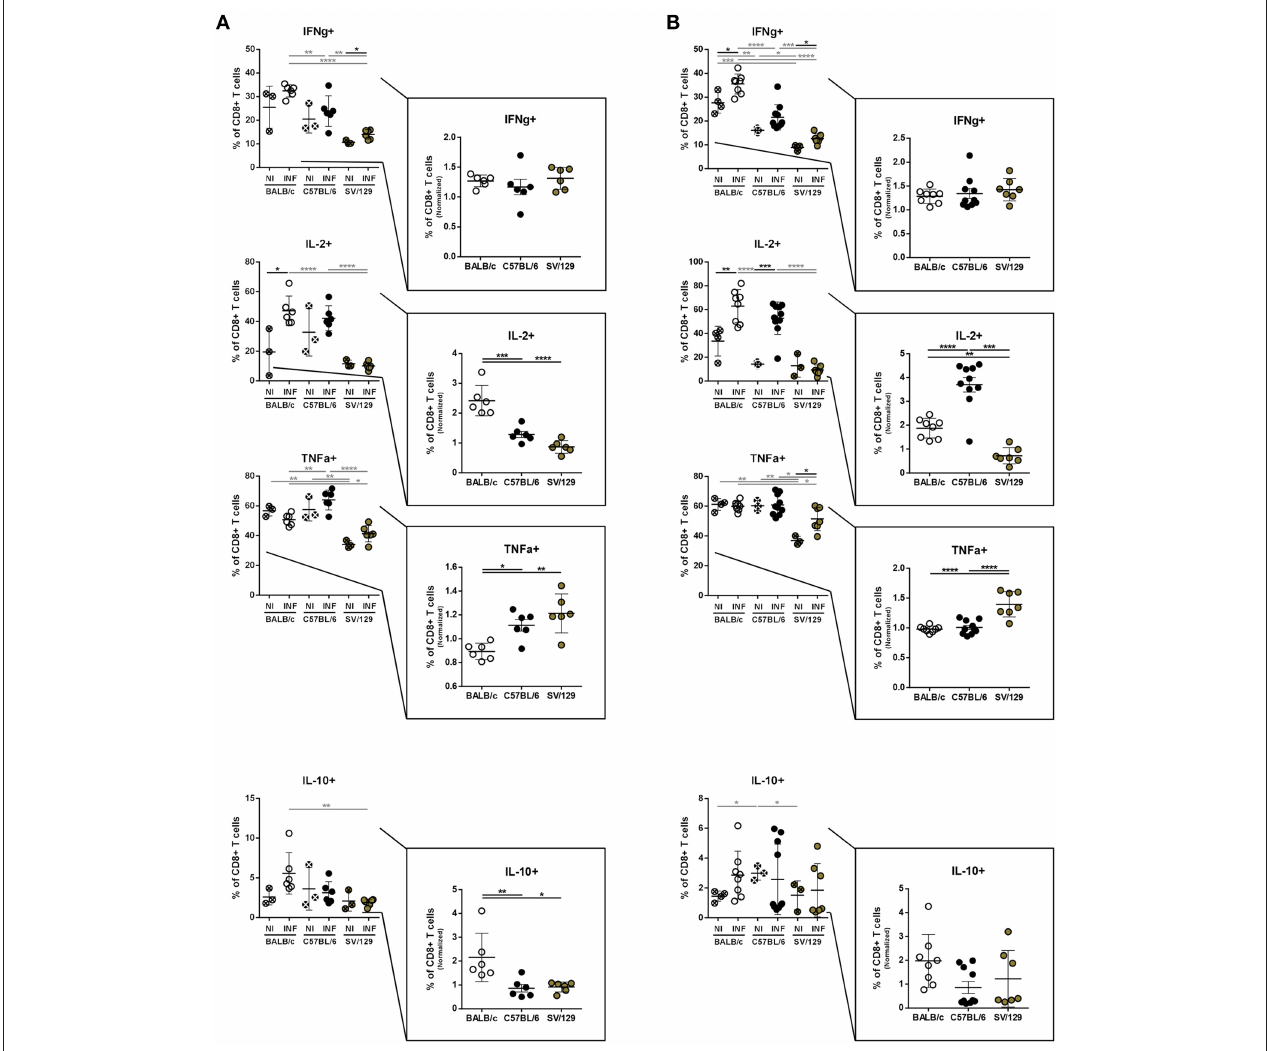
FIGURE 5 | Basal intracellular cytokine production by CD8 + T cells of the different mouse strains and it’s alteration 2- and 8-weeks post L. infantum infection. BALB/c (white circles), C57BL/6 (black circles) and SV/129 (brown circles) mice were infected intraperitoneally with 1 × 10 8 L. infantum promastigotes and euthanized 2 or 8 weeks after. Splenocytes were cultured with PMA + Ionomycin + Brefeldin A for 4h. CD8 + T cell frequencies producing IFN- γ , IL-2, TNF- α , and IL-10 were resolved by flow cytometry and are denoted for two (A) and 8 (B) weeks-infected animals and their respective controls. Results, obtained in at least two independent experiments, are represented both in total percentages (infected and control animals) and normalized (infected in relation to control group average values) as a way to highlight the infection-induced alterations. Each dot represents an animal. Average and SD of the values within each group are shown. Statistical differences are properly identified. One Way ANOVA (with Tukey’s post-hoc analysis) was used for comparisons between the different murine strains (infected or non-infected; gray lines), as well as for comparison of normalized values (black lines); t -tests (black lines) were performed for comparison between infected animals and controls from the same strain: * p ≤ 0.05, ** p ≤ 0.01, *** p ≤ 0.001, and **** p ≤